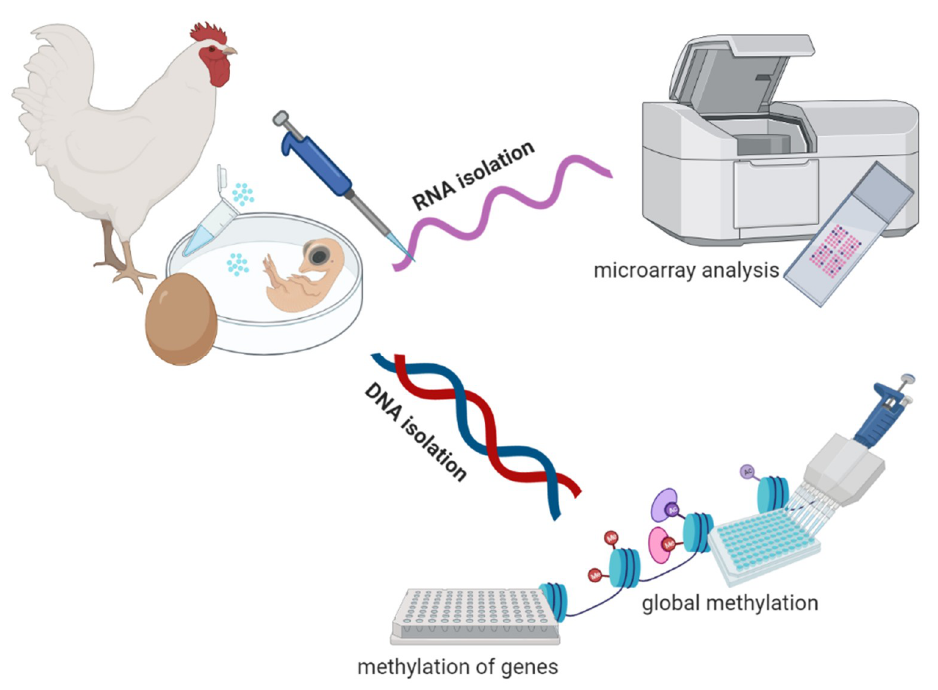
Figure 1. Experimental set-up (created with BioRender.com).